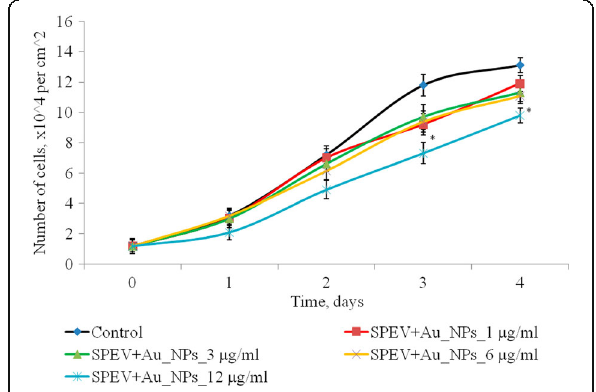
Fig. 4 Proliferation of SPEV cells after exposure of AuNPs, * p ≤ 0.05